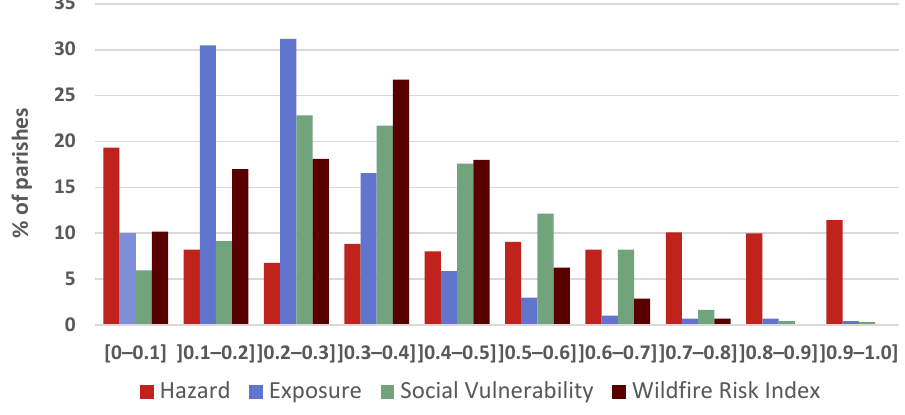
Figure 9. Frequency distributions for the wildfire risk index and its components.